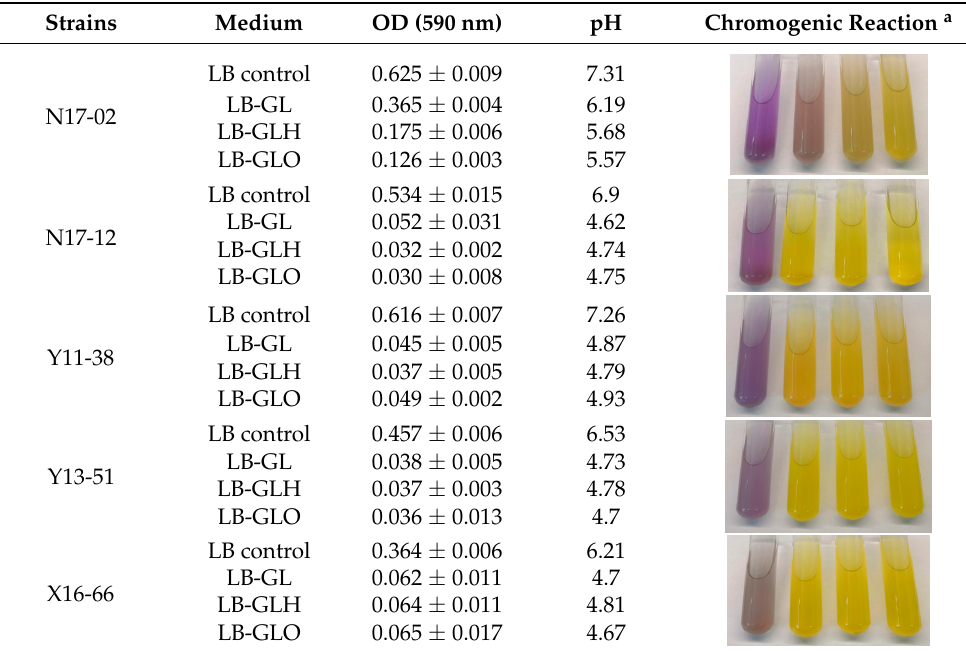
Table 2. Representative results of strains passing the biogenic amine formation assay.